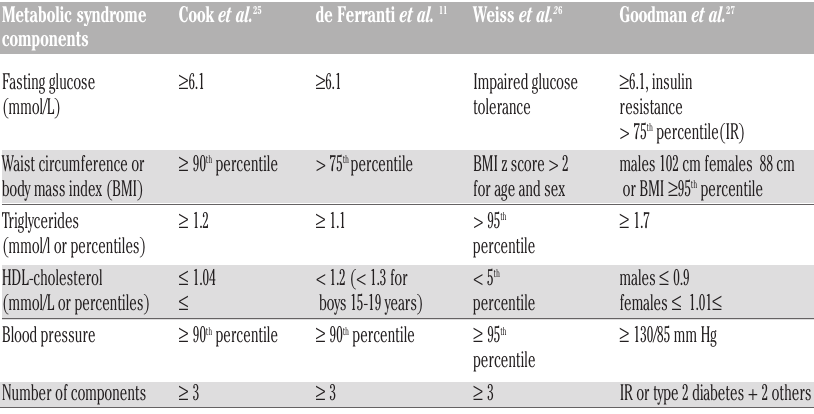
Table 3. Comparison of the metabolic syndrome criteria used in some pediatric